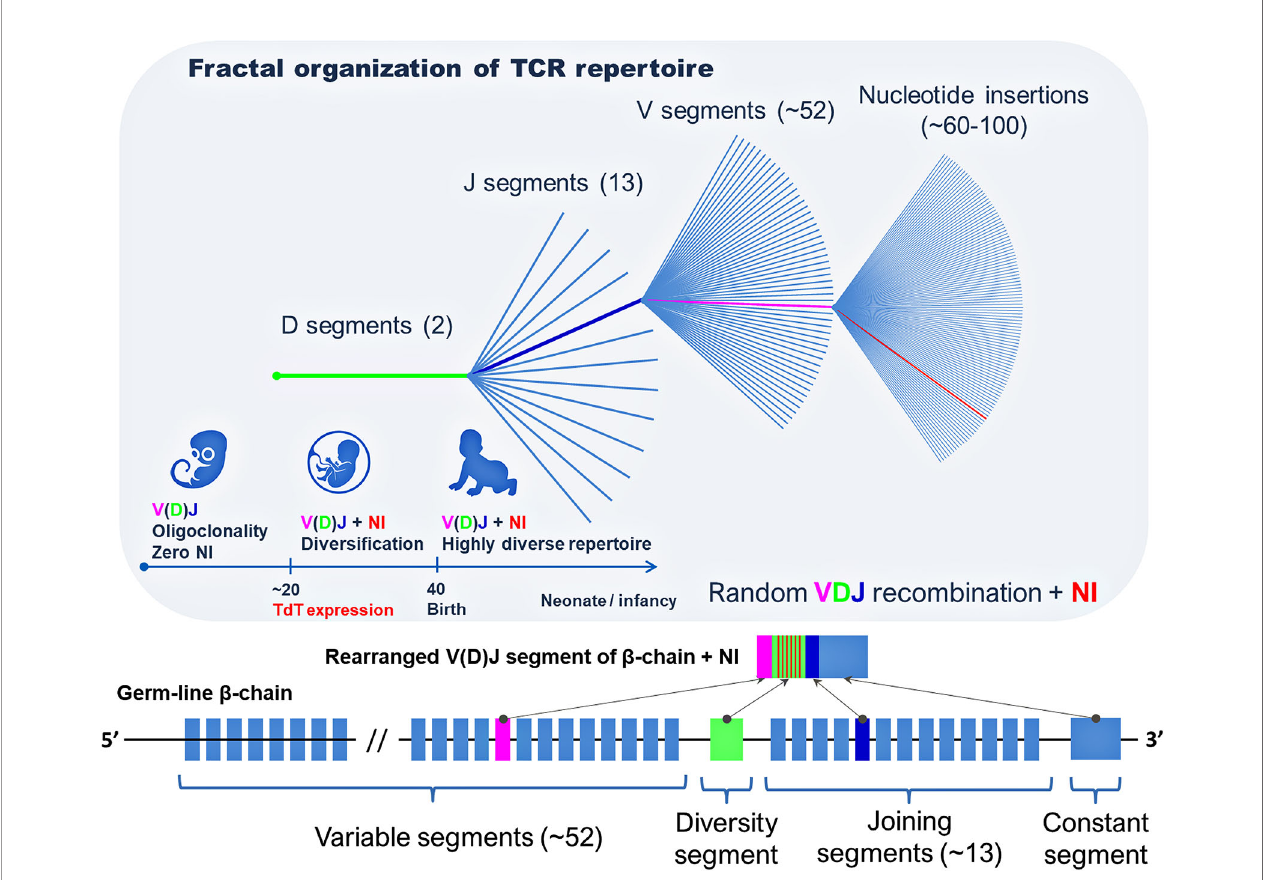
FIGURE 2 | Fractal organization of T-cell repertoire. A fractal is a set with self-similarity (an object that exactly or approximately coincides with a part of itself, similar to itself on any magni fi